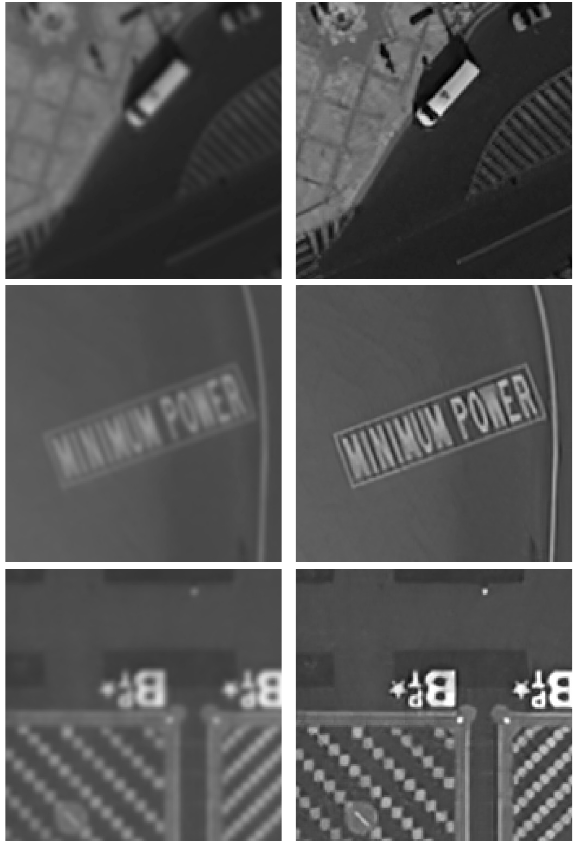
Figure 7 Results on PNeo imagery Left: Pleiades Neo L1B with nominal image restoration, after bicubic upsampling Right: Output from model prediction taking L1A ( unrestored image) as input